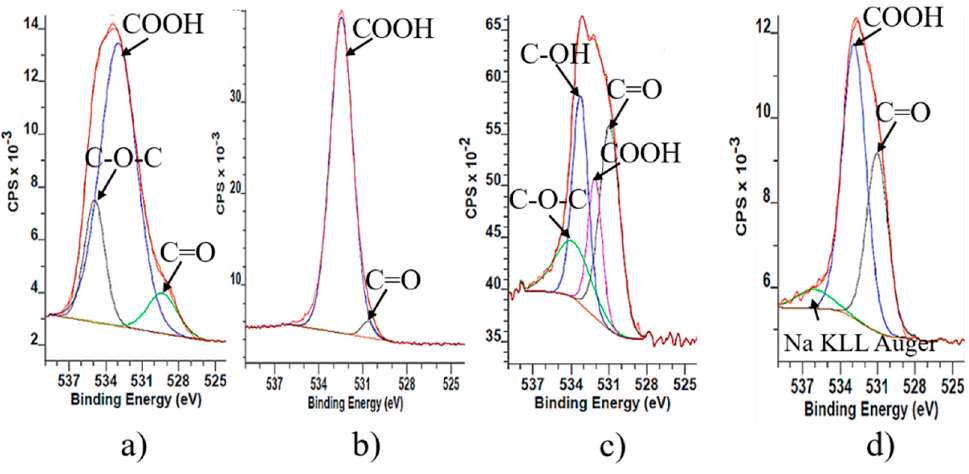
Figure 2. O1s XPS spectra of graphene oxide samples: ( a ) GO; ( b ) bwGO; ( c ) rGO and ( d ) rbwGO.